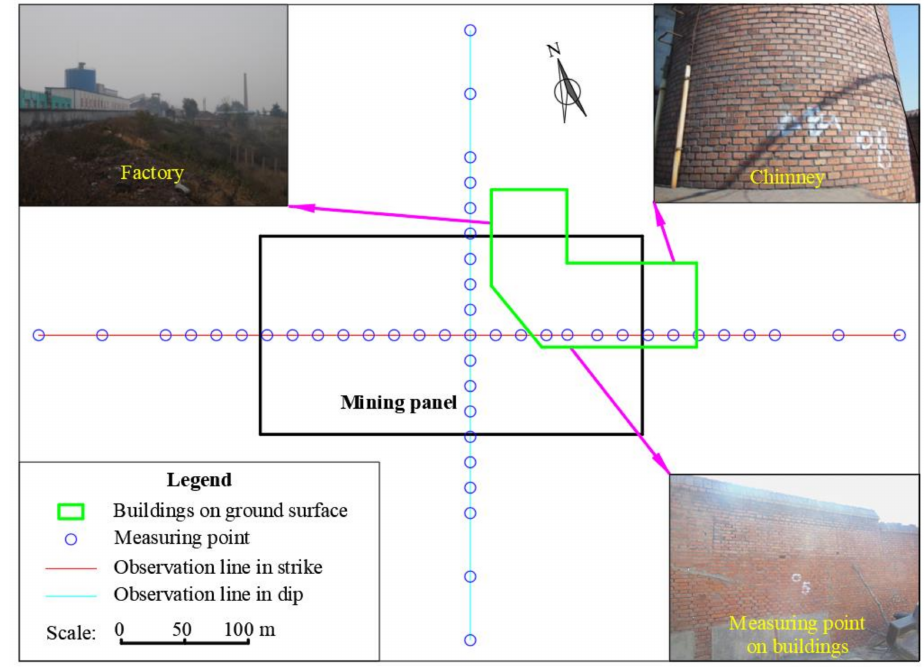
Figure 2. Buildings on the ground above the mining panel and arrangements of measuring points.